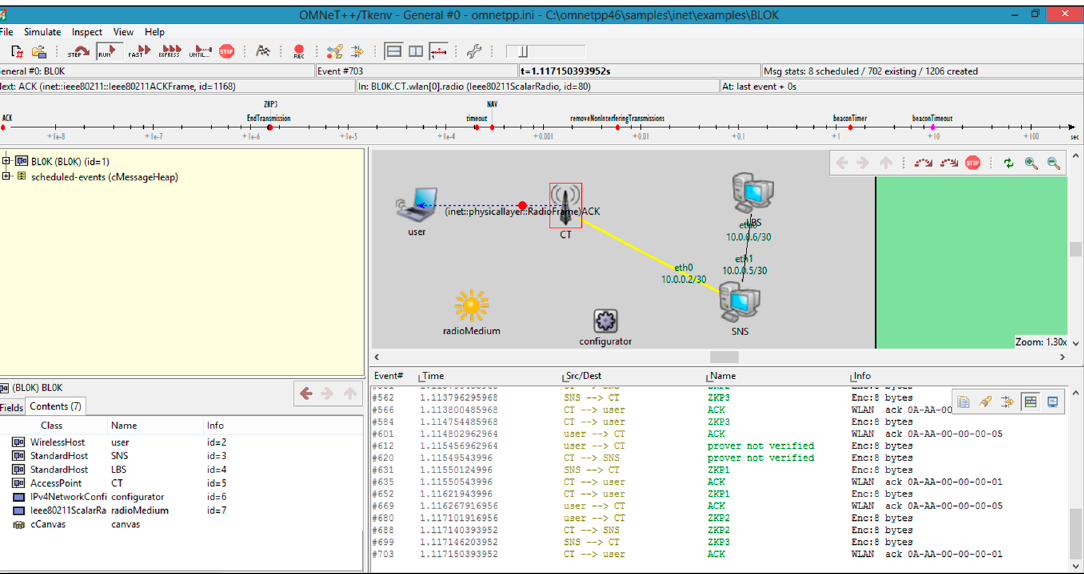
Figure 10. A snapshot of BL0K modeling.